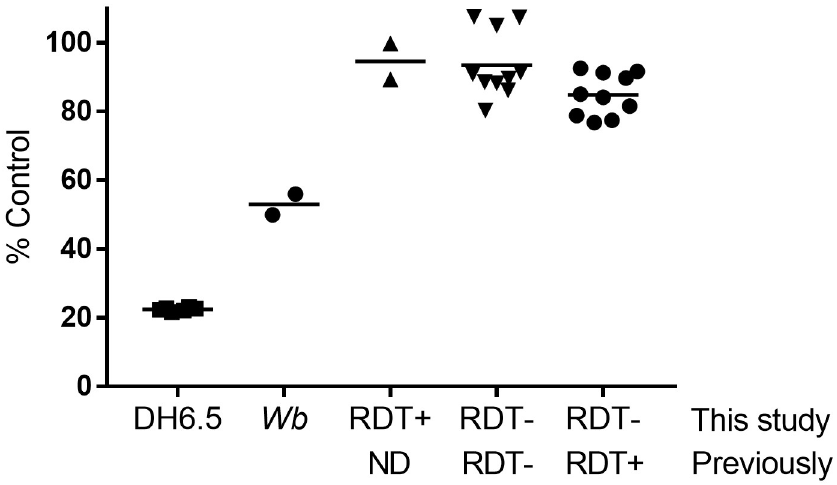
Fig 2. Loiasis patient sera lack antibodies specific to the AD12 carbohydrate epitope. Serum samples were tested for the ability to block AD12 binding to B . malayi antigens that contain the AD12 epitope. The horizontal line denotes the mean value for each